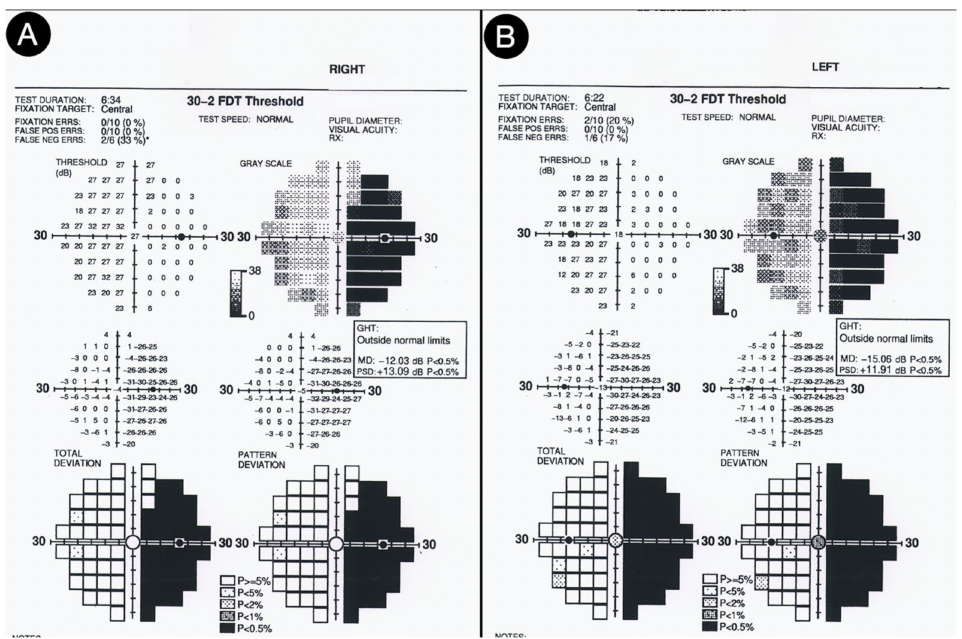
Figure 16. Preoperative visual field test of the right ( A ) and left ( B ) eye.